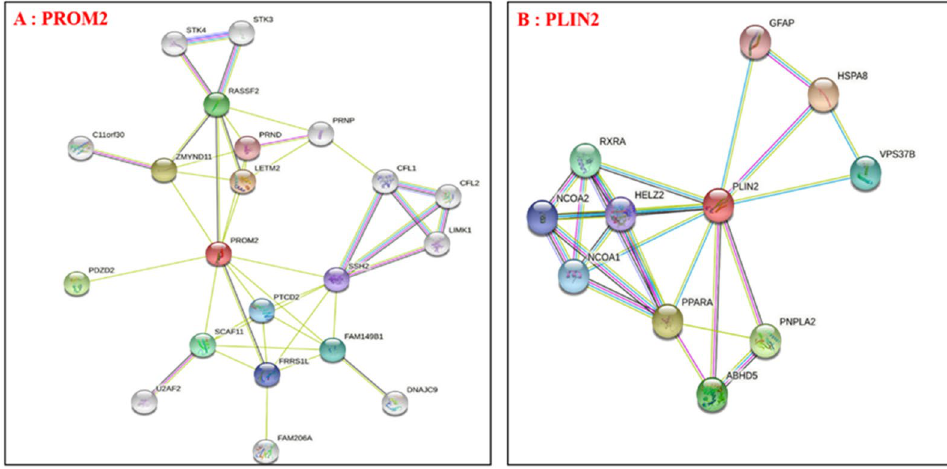
Figure 11. Protein–protein interaction of PROM2 ( A ) and PLIN2 ( B